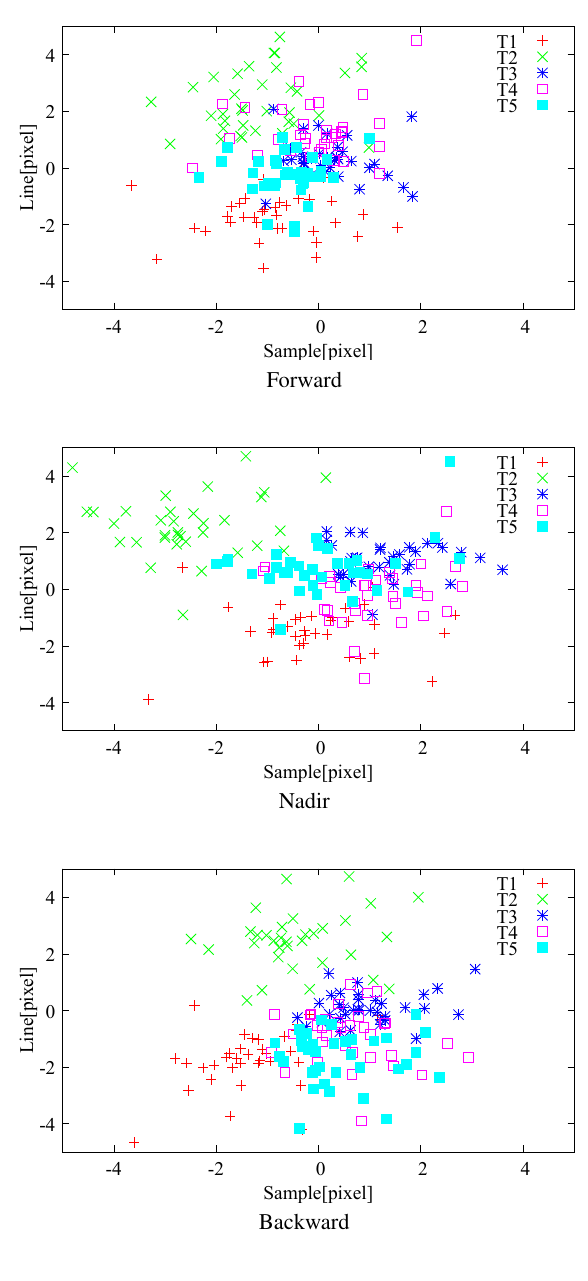
Figure 4. Scattergram of errors of image coordinates estimated by using the standard RPC model without bias